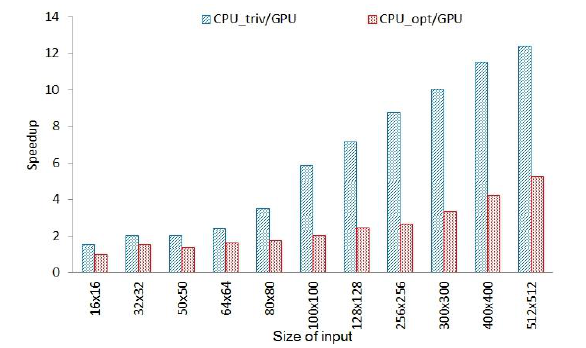
Figure 6. Execution time